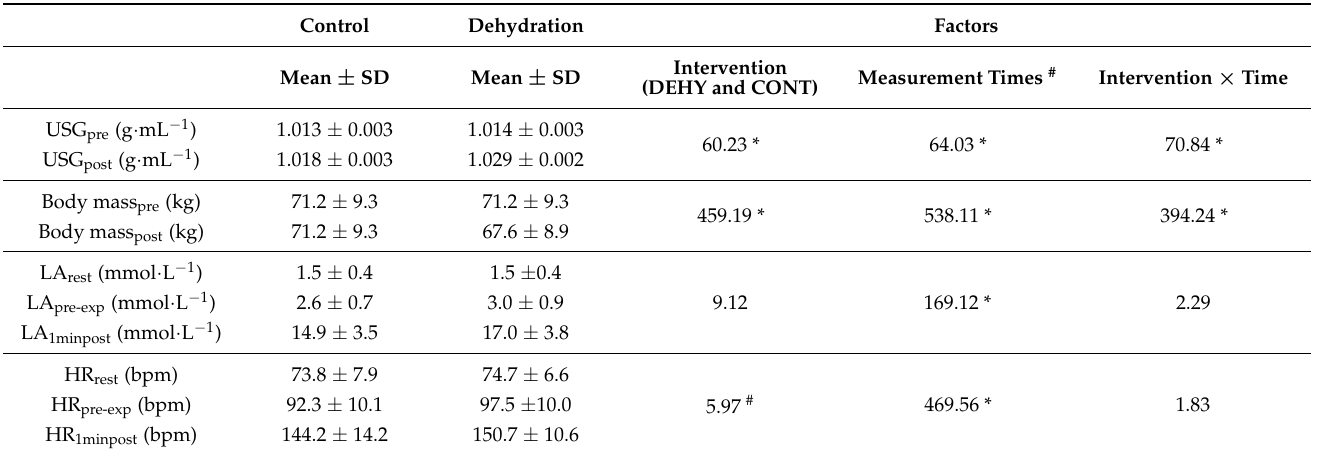
Table 1. Hydration, body mass, LA, and HR changes in the CON and DEHY